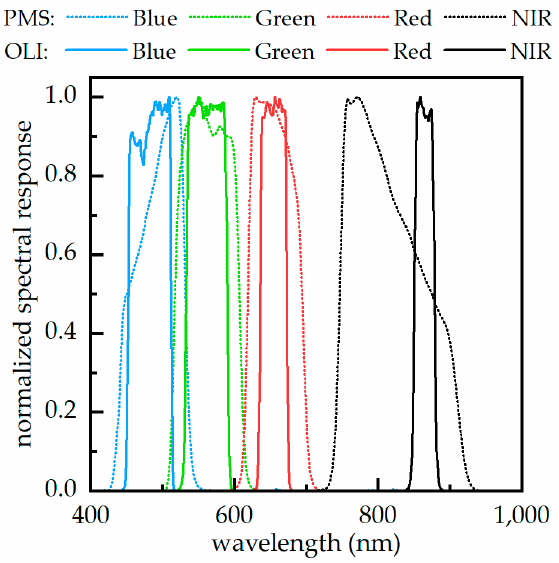
Figure 2. The spectral response functions of the GF-4 PMS and Landsat-8 OLI.